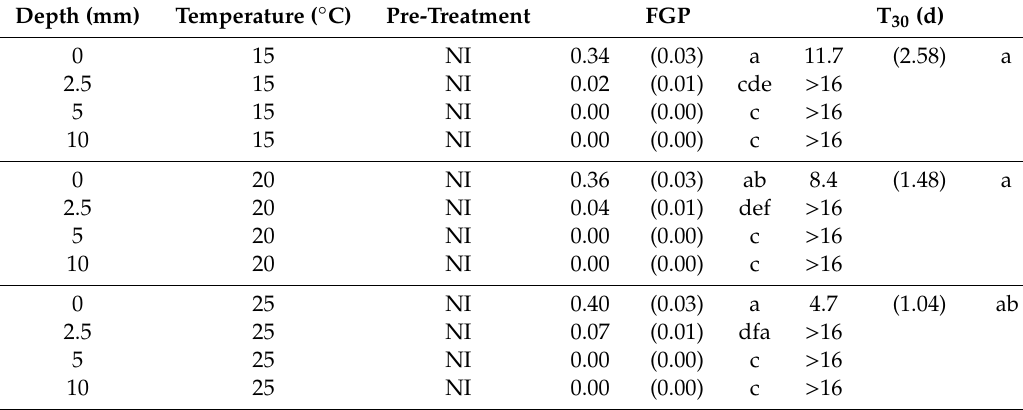
Table 2. Influence of sowing depth, temperature and seeds pre-treatment (I: water imbibition and light exposure for two days; NI: no water imbibition and no light exposure) on maximum proportion of emerged plants (FGP, Final Germination Proportion) and time to 30% emergence (T 30 ) for C. canadensis. Standard errors are in